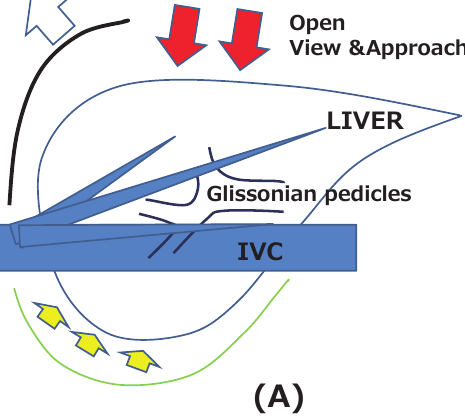
Figure 1. Differences between approaches for open and laparoscopic liver resection.